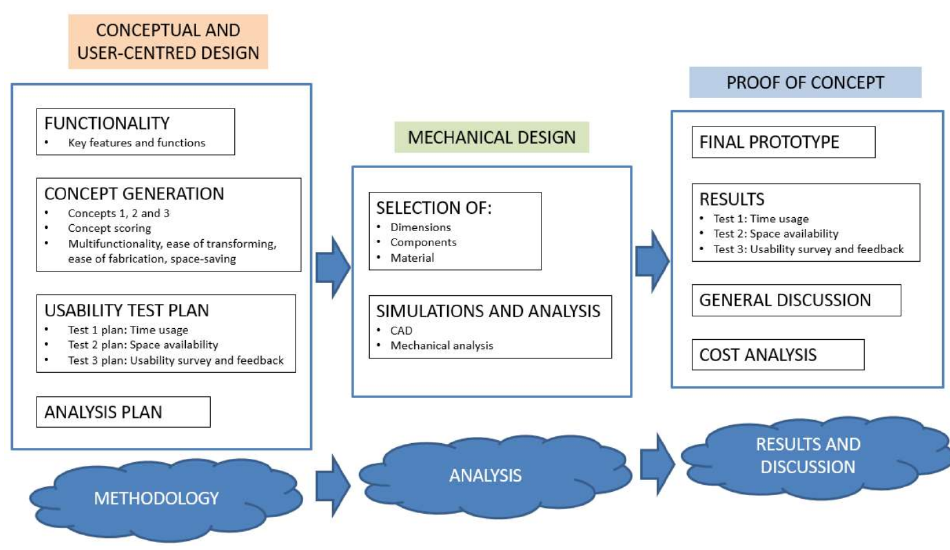
Figure 1. Design process for the space-saving multipurpose